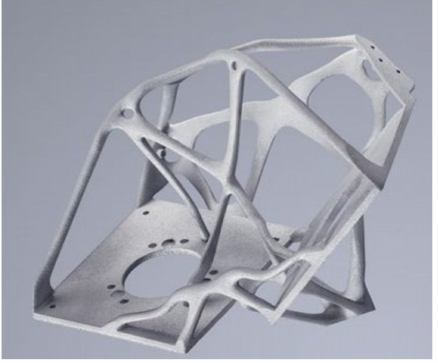
Figure 13. Camera Head Unit (CHU) bracket